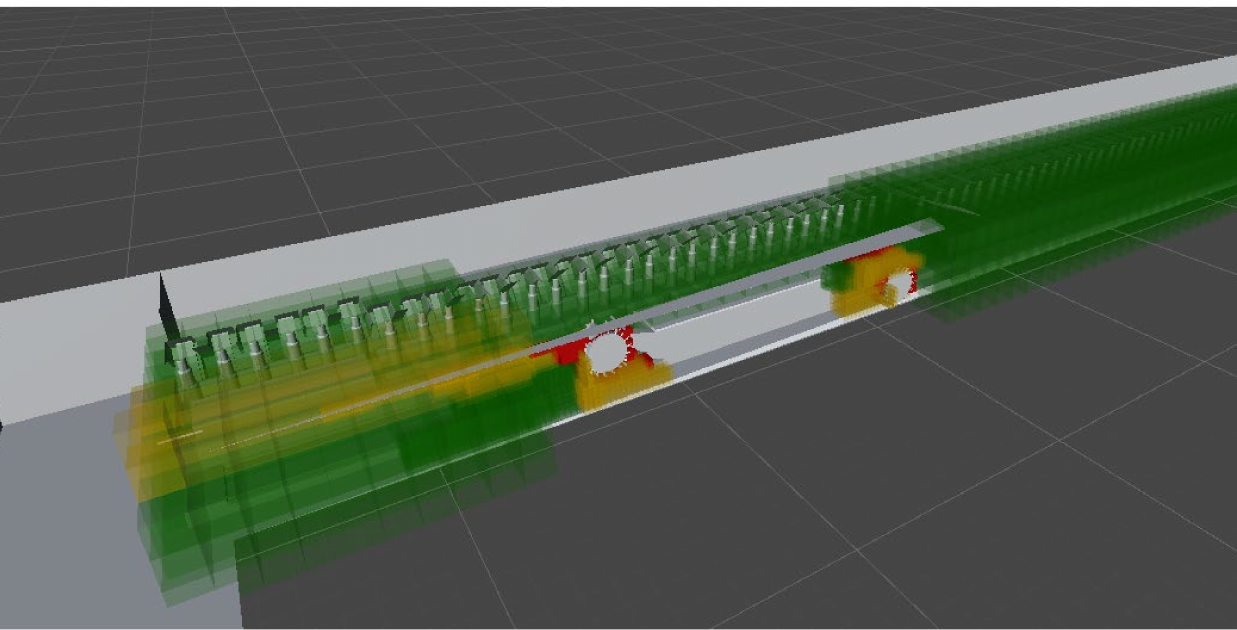
Figure 2. Six locations of the shearer and cutting directions during data collection. Figure 3 represents a snapshot of the 120th second of location 3 as an example. Other locations and timestamps acted similarly; to avoid redundancy only one example is provided.